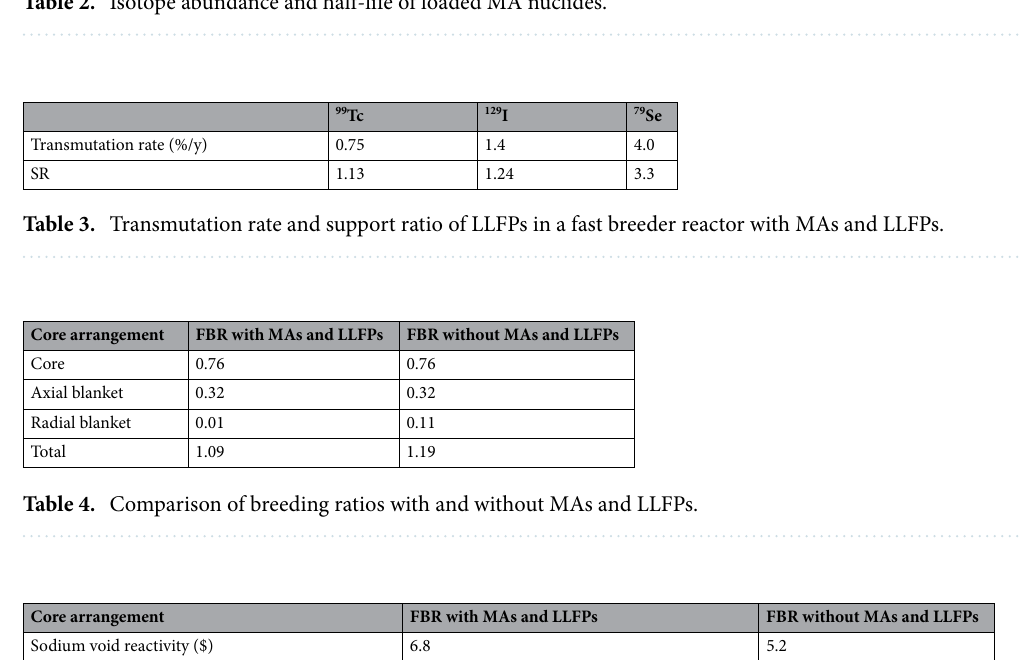
Table 2. Isotope abundance and half-life of loaded MA nuclides.